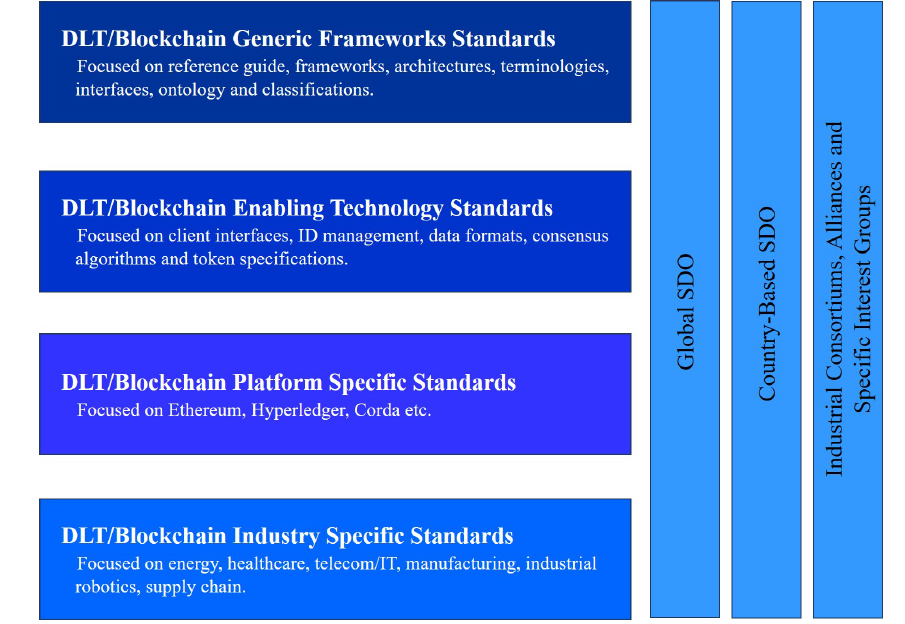
Figure 5. The classification of DLT/Blockchain